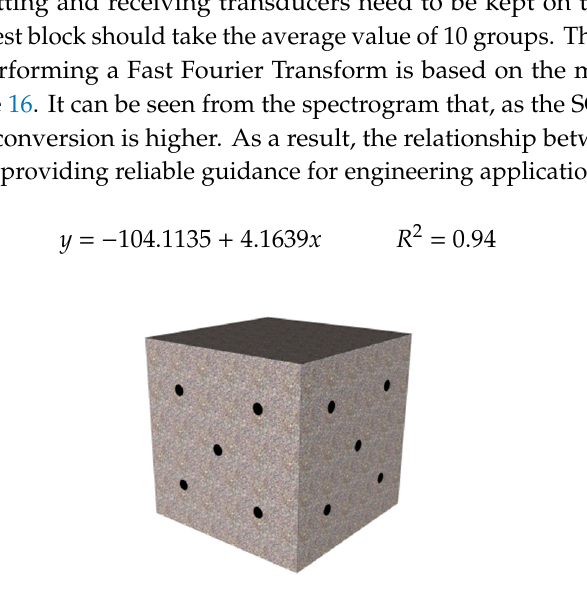
Figure 14. Mohr-Coulomb criterion.